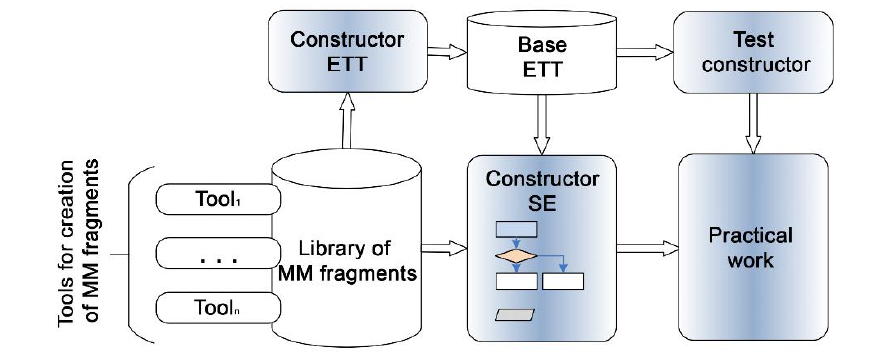
Fig. 4. Instrumental means of practical work